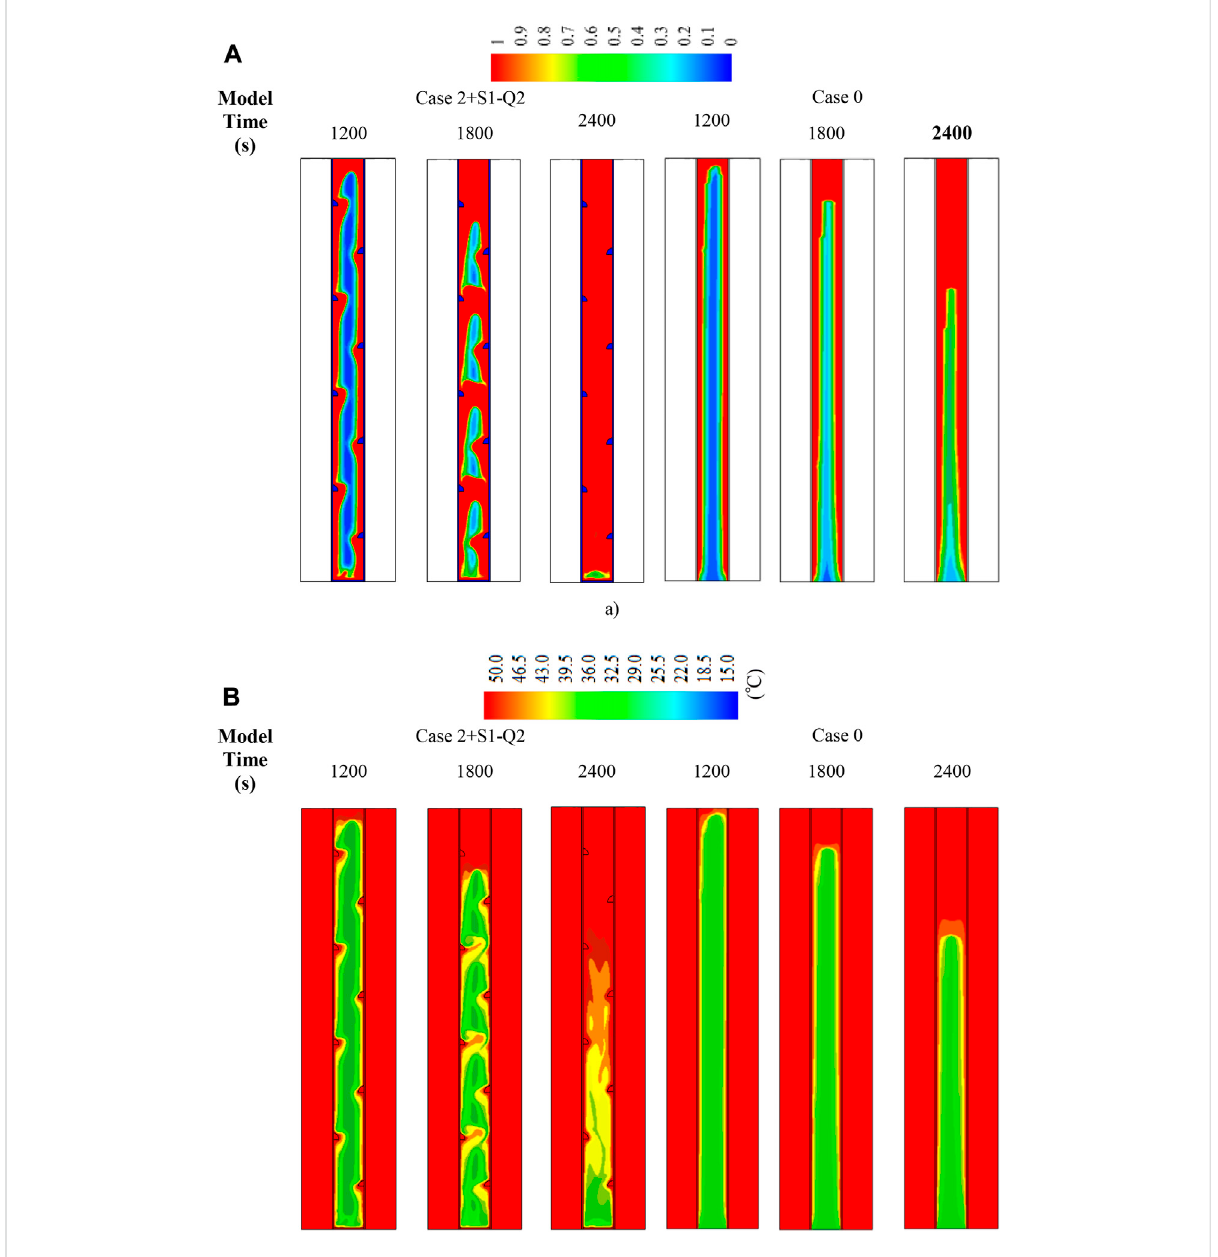
FIGURE 11 (A) Liquid fraction and (B) temperature contours of thePCM for eight quadrants ’ upward curveview, leftstaggered fi ns,and added fl at fi ntothe base of the PCM domain, and the case with no- fi